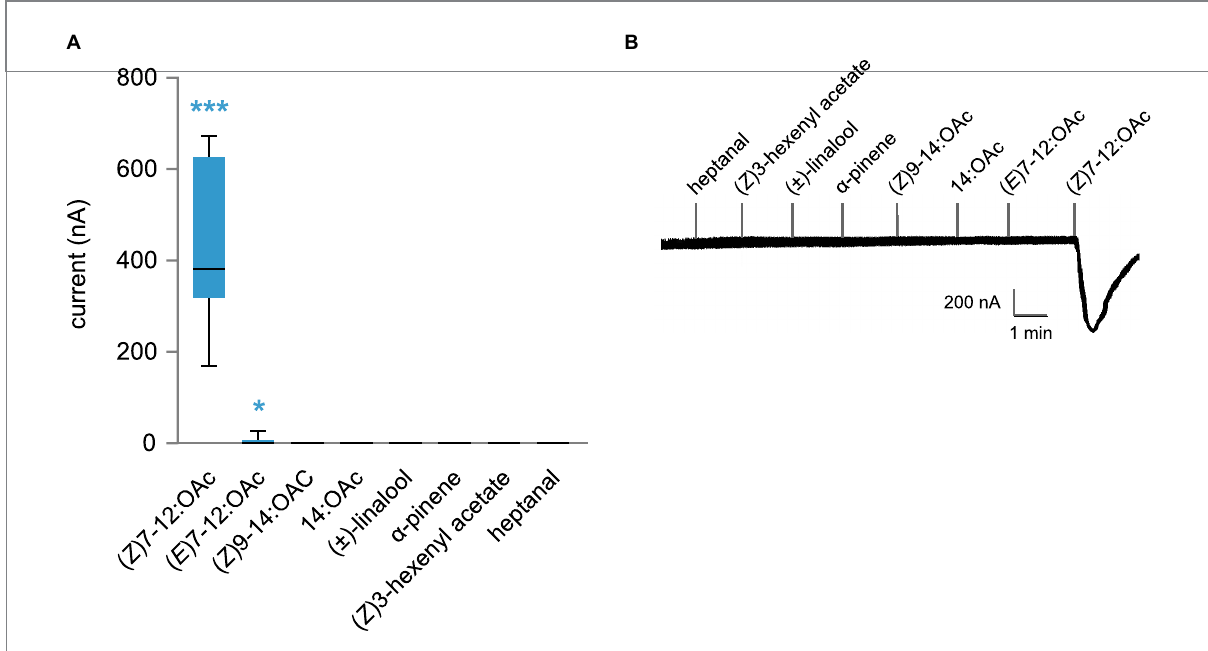
FIGURE 3 Functional analysis of AipsOR3 expressed in Xenopus oocytes. (A) Inward current measured by two-electrode voltage clamp in oocytes co- expressing AipsOR3 and AipsOrco in response to four moth pheromone compounds (10 − 5 M) and four volatile plant compounds (10 − 4 M). Boxes show the median and the first and third quartiles, and whiskers show the minimum and maximum values of the distribution ( n = 12–17). *** p < 0.001, * p < 0.05, significantly different from 0 (Wilcoxon signed rank test). (B) Representative TEVC recording obtained for a Xenopus oocyte co- expressing AipsOR3 and